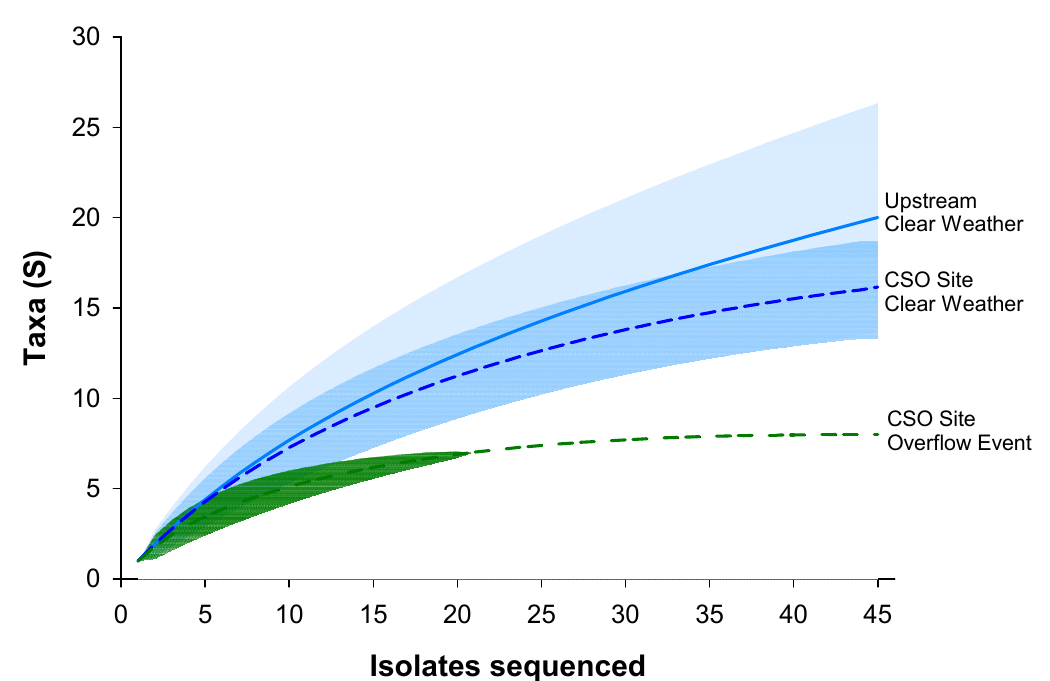
Figure 5. Rarefaction curves for genus-level classification of isolates. Shading represents 95% confidence intervals.